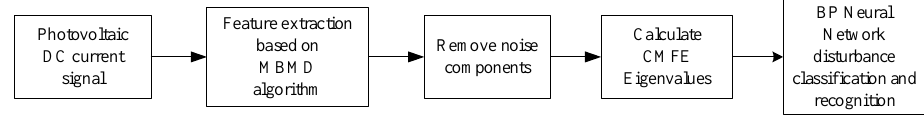
Table 3. Evaluation parameters of the three algorithms (SNR 5).